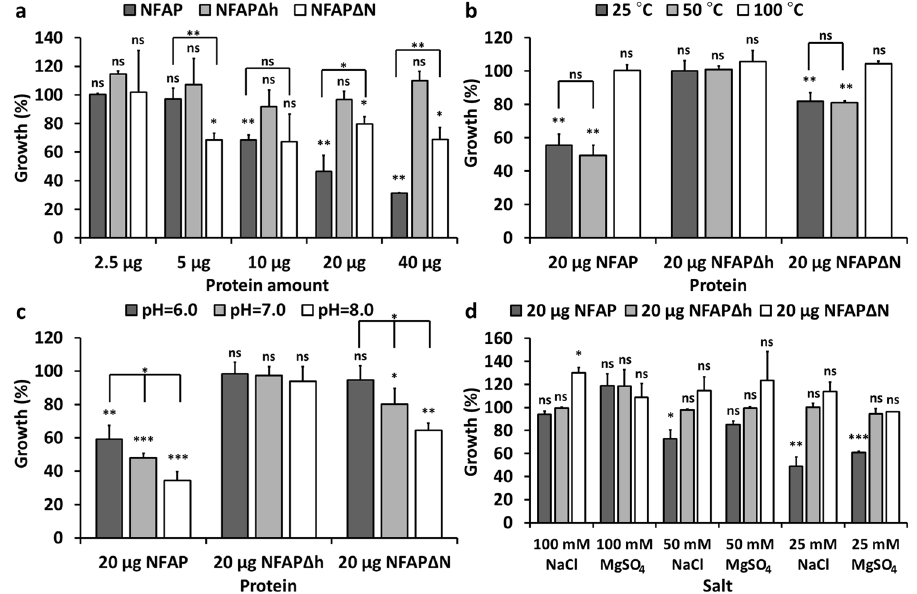
Figure 4. Antifungal activity of recombinant NFAP, NFAP Δ h, NFAP Δ N in broth microdilution tests. ( a ) Growth of Aspergillus nidulans FGSC A4 at pH 7.0 in the presence of 2.5–40 μ g NFAP, NFAP Δ h, and NFAP Δ N; and with 20 μ g of NFAP, NFAP Δ h, and NFAP Δ N after ( b ) heat-treatment at pH 7.0, ( c ) at different pH, and ( d ) in salt supplemented medium at pH 7.0. In all cases the untreated control cultures was referred to 100% growth. Significant differences (p-values) between the growth percentages were determined based on the comparison with the untreated control. When the growth percentages were compared in significance test, they are connected with line. *** p < 0.0001, ** p < 0.005, * p < 0.05, ns: no significant difference. NFAP: recombinant Neosartorya fischeri NRRL 181 antifungal protein; NFAP ∆ h: hydrophobic core deletion NFAP mutant; NFAP ∆ N: N-terminal amino acids exchanged NFAP